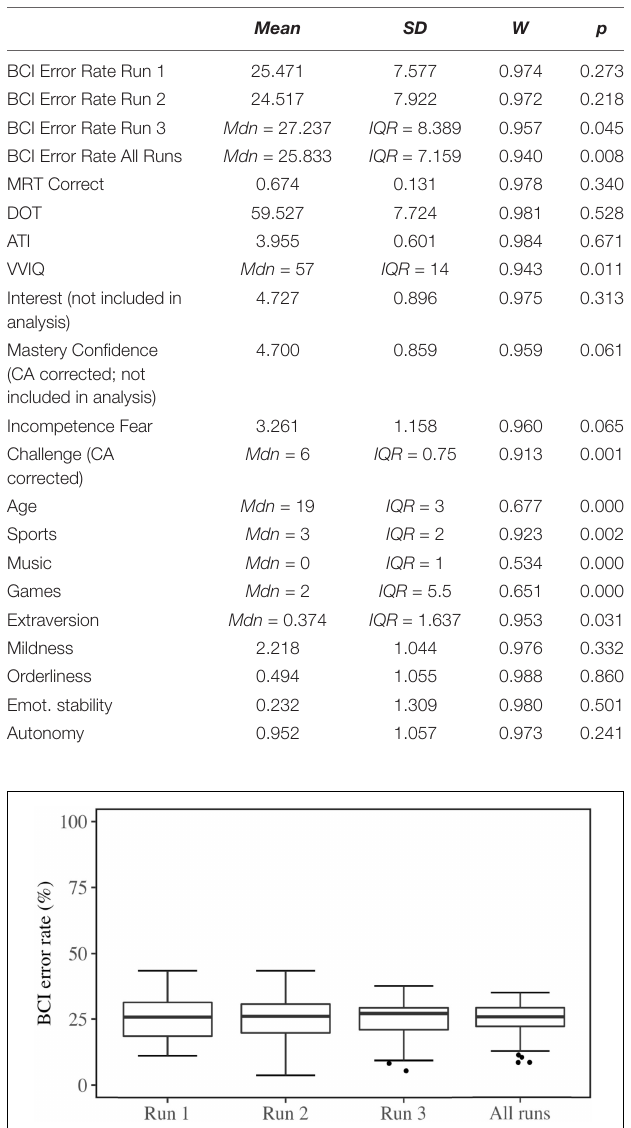
TABLE 1 | Summary statistics of included variables.